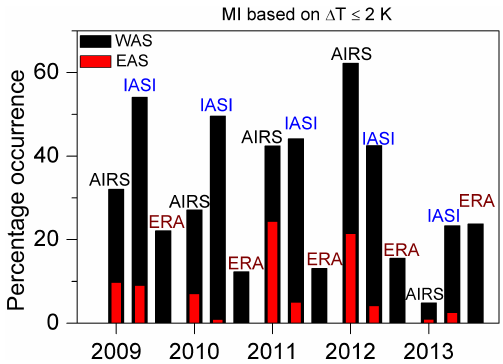
Figure 8. Percentage occurrence of MI observed with (cid:49)T ≤ 2K using IASI, AIRS and ERA-Interim data during monsoon seasons of 2009–2013 over the WAS and